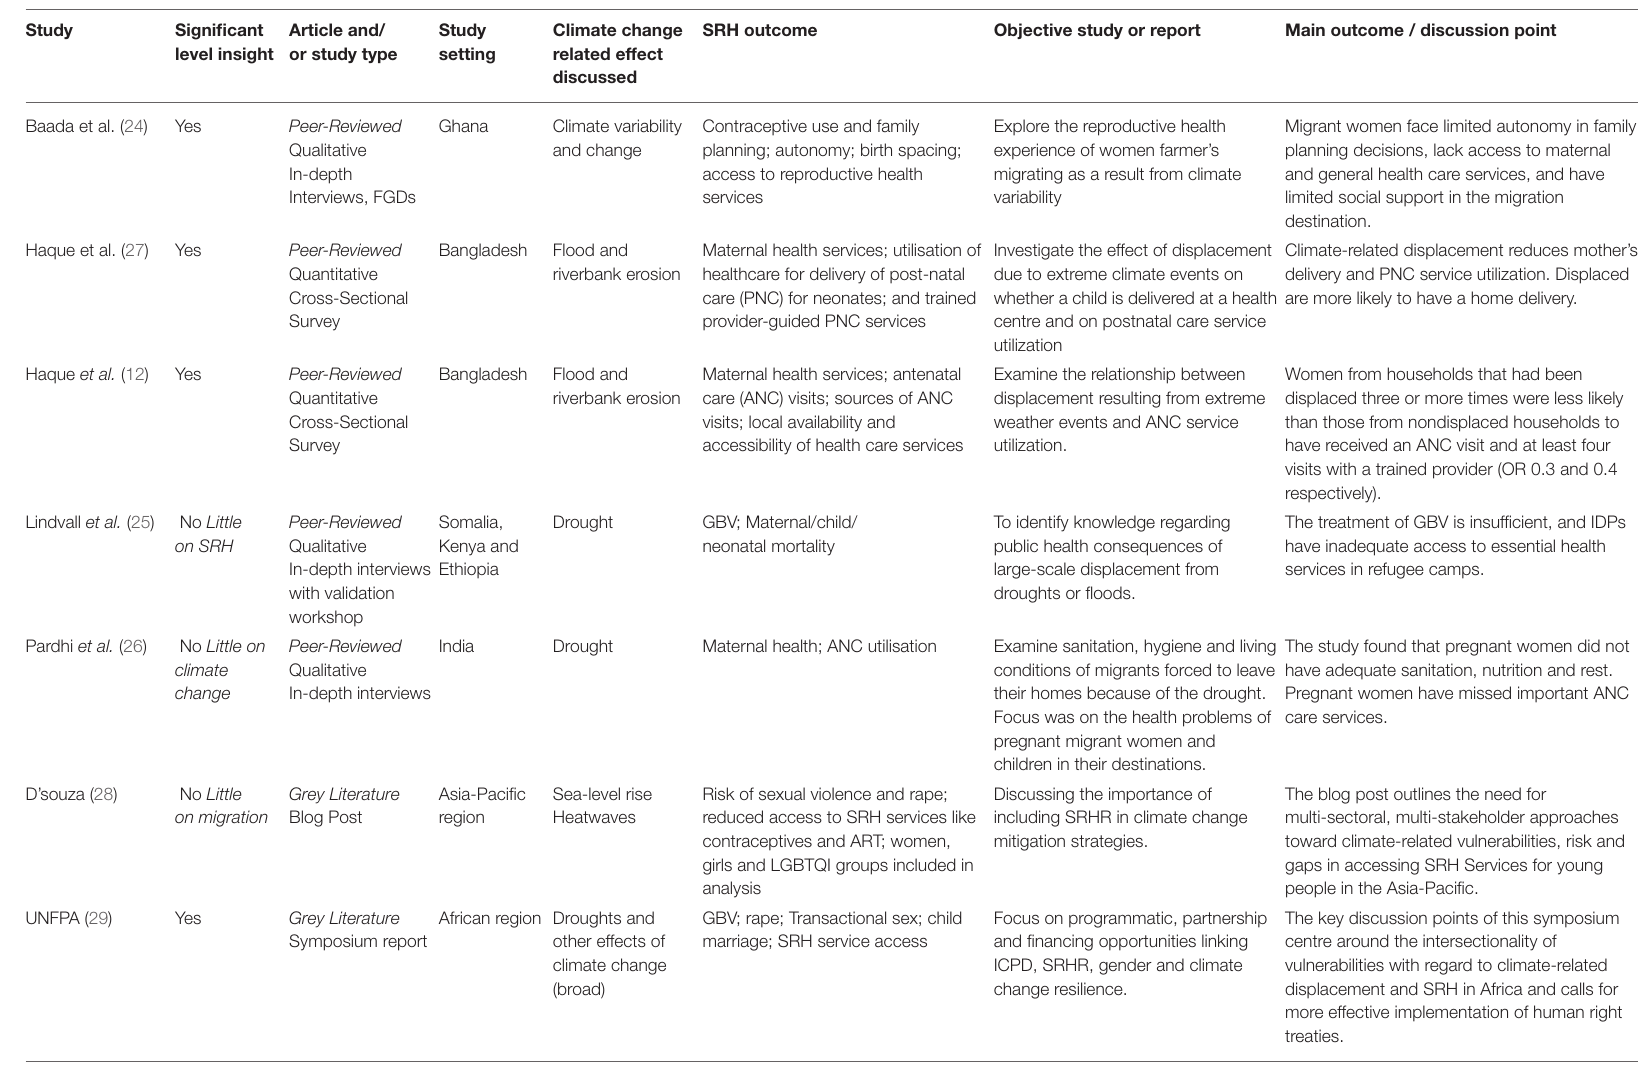
TABLE 1 | Summary characteristics of included